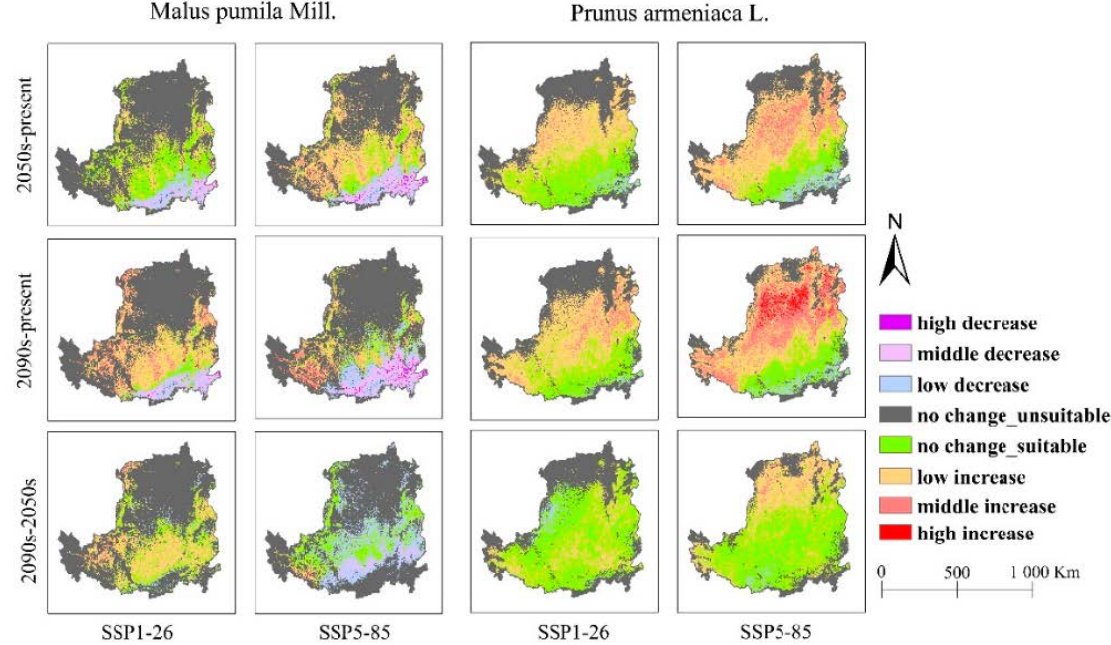
Figure 5. Increase and decrease maps of suitability for 2050s–present, 2090s–present and 2090s–2050s periods. Changes in the suitable area and habitat suitability resulted in changes in the cen- troids. The centroid of the current habitat of M. pumila and P. armeniaca was located at 109°36 ′ 55.96 ″ E, 35°54 ′ 12.87 ″ N and 109°12 ′ 53.28 ″ E, 36°15 ′ 19.23 ″ N, respectively (Figure 6). For M. pumila , under SSP1-26, the shift distances were 78.61 km and 90.20 km for the 2050s and the 2090s, while the shift distances were 132.57 km and 190.63 km under SSP5-85. For P. armeniaca , the shift distances were 72.08 km and 64.77 km for the 2050s and the 2090s under SSP1-26, while they were 101.89 km and 139.85 km under SSP5-85. Overall, for both M. pumila and P. armeniaca , we observed that the centroids of future suitable hab- itats (2050s, 2090s) shifted towards the northwest under both future emission scenarios (SSP1-26, SSP5-85). Figure 6. Suitable habitat centroids of Malus pumila Mill and Prunus armeniaca L . in present, 2050s and 2090s periods under the Shared Socioeconomic Pathways (SSPs) SSP1-26 and SSP5-85. ( a ) Yel- low area shows the study area, the Loess Plateau, in relation to China. ( b ) Black box shows the